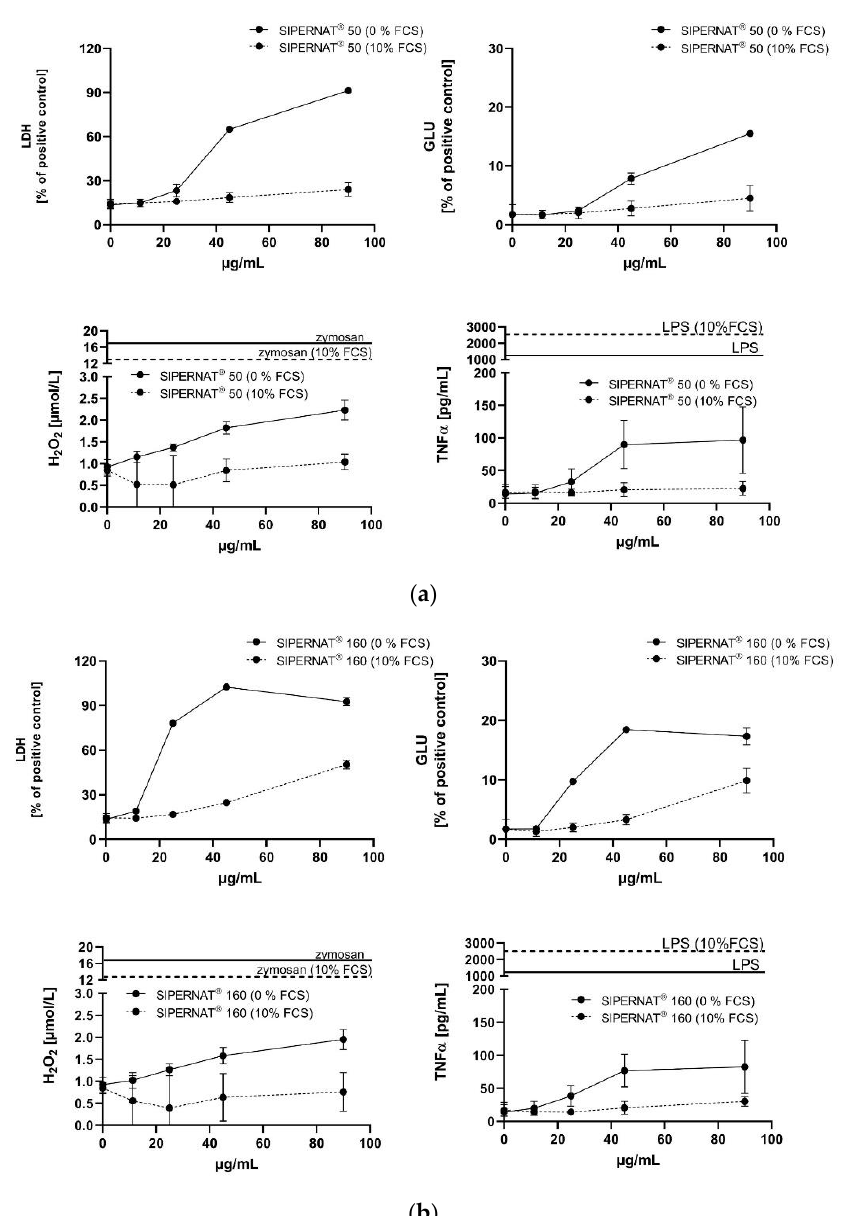
Figure 7. In vitro response of NR8383 alveolar macrophages to SIPERNAT ® 50 and SIPERNAT ® 160 in the absence or in the presence of FCS (dashed lines). Lactate dehydrogenase activity (LDH), glucuronidase activity (GLU), H 2 O 2 concentration and tumour necrosis factor alpha (TNFα) were measured in the supernatant from NR8383 cells exposed to SIPERNAT ® 50 ( a ) or SIPERNAT ® 160 ( b ). Effects of zymosan and lipopolysaccharide (LPS) on the formation of H 2 O 2 and TNFα, respectively, are indicated by vertical lines.